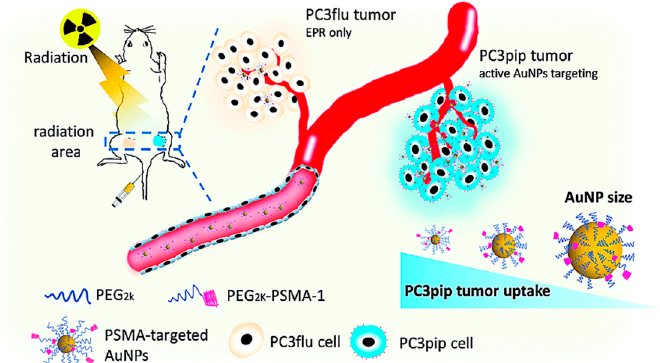
Figure 7. Scheme illustration of targeted prostate cancer radiotherapy using PSMA-targeted AuNPs of various sizes. Reproduced from [158] with permission from Royal Society of Chemistry, 2019.